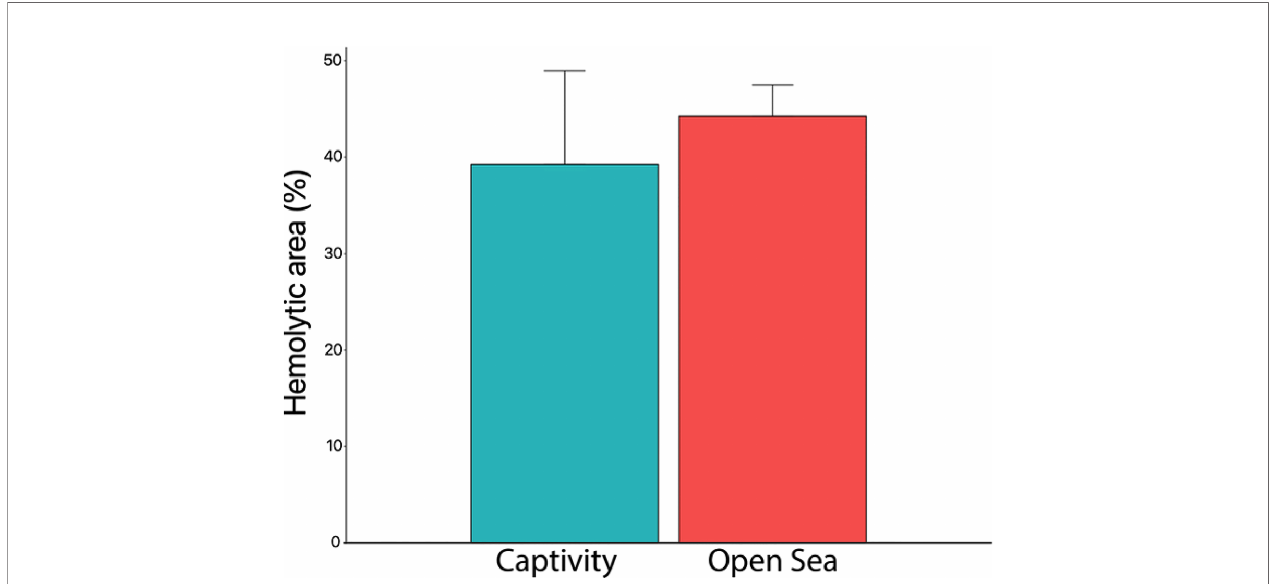
FIGURE 7 | Hemolytic area (%) produced by the venom from captive and open-sea jelly fi sh. No signi fi cant differences were observed between jelly fi sh from the open sea and those from captivity (p value 0.2) (Mann – Whitney test). Captivity replicates, n = 10; open sea replicates, n =